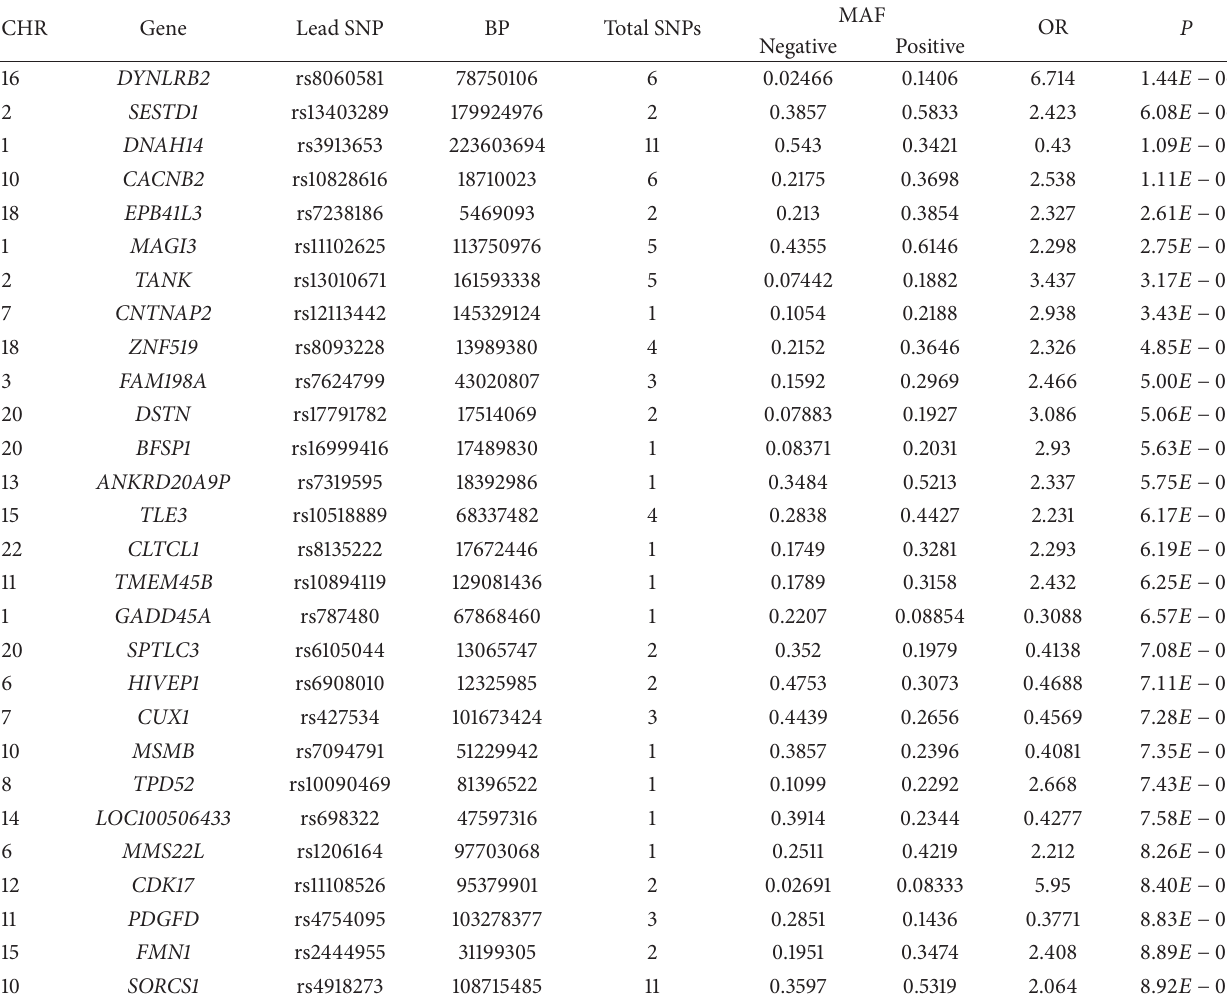
Table 5: Genetic loci associated with the occurrence of two or more antiphospholipid antibodies (ACL, LAC, or Anti- 𝛽 2 GPI) with 𝑃 < 1𝐸 − 04 ∗